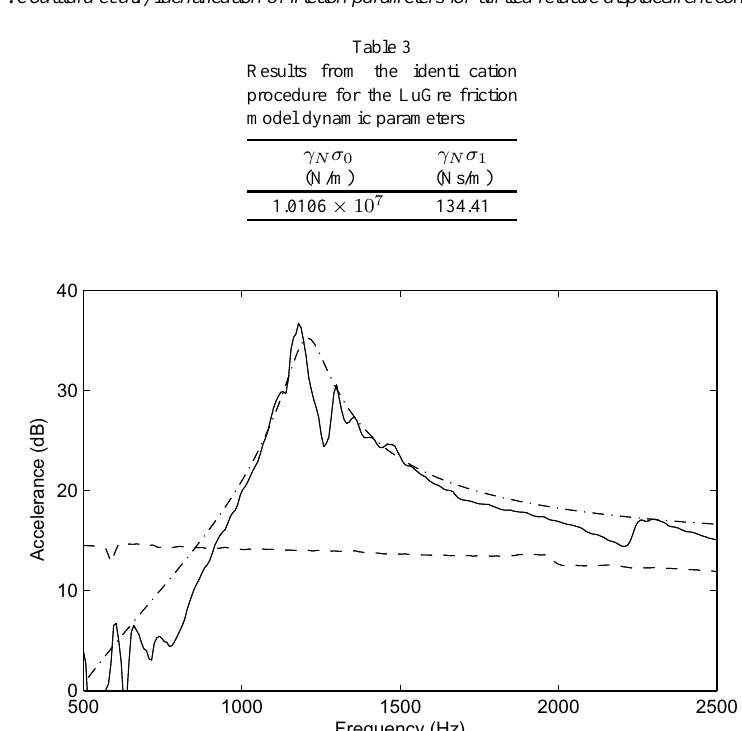
Fig. 10. Frequency domain identification of the LuGre friction model dynamic parameters for the set-up with the Br¨uel and Kjaer 4809 shaker. Experimental frequency response function ( −− ), theoretical frequency response function from identification ( ·−· ) and experimental frequency response function without friction force applied (- - -).